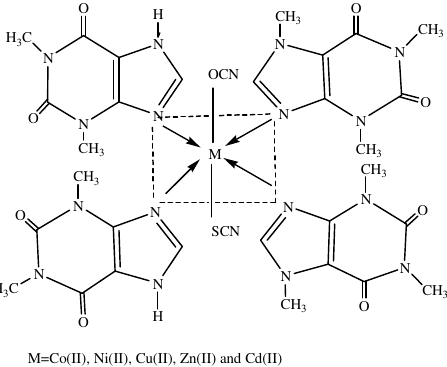
Figure 1. Structure of the prepared complexes [M(Tx)